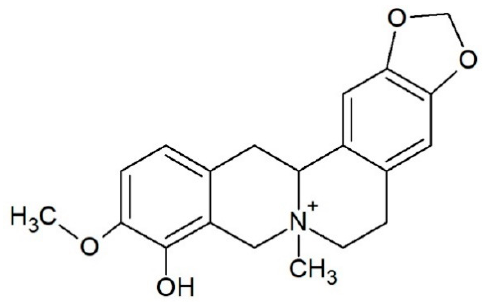
Figure 1. Structure of alkaloid escholidine.